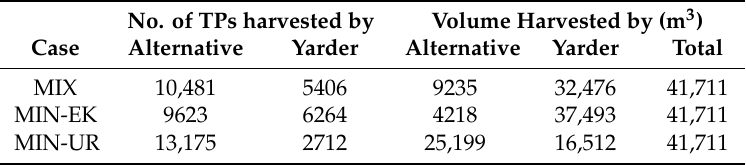
Table 9. CR and harvesting layouts properties of tested areas in Gotschna. The corresponding visualizations can be found in Figures 11–13.